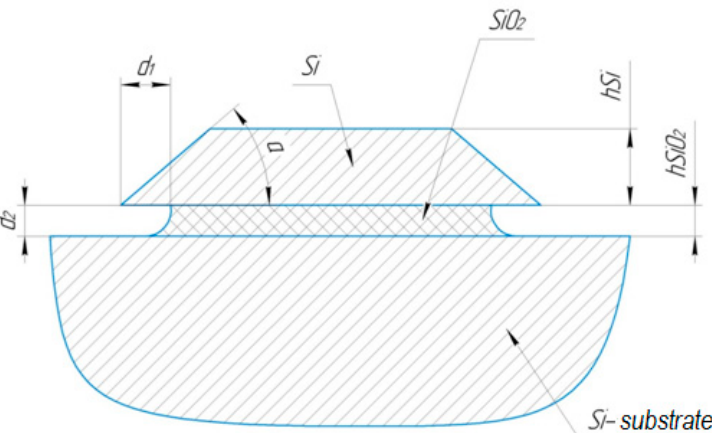
Figure 8. Schematic of the cross-section of the structure of the silicon WGM waveguide. Environment is air. h si , the thickness (height) of the wedge-shaped waveguide; h SiO2 , thickness (height) of the dielectric layer; d 1 , distance from the edge of the wedge to the beginning of the oxide beam (support); d 2 , the gap between the edge of the wedge-shaped waveguide and the Si substrate; a, wedge angle [19].